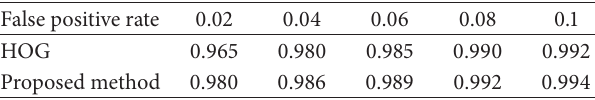
Table 1: The detection rates of various detectors.